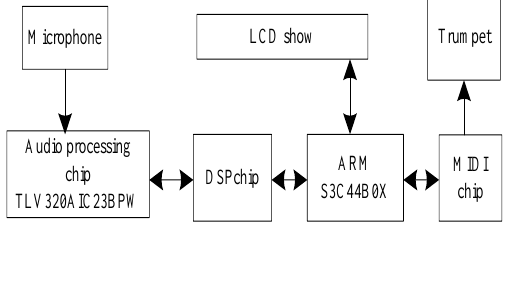
Figure 2. Diagram of system hardware